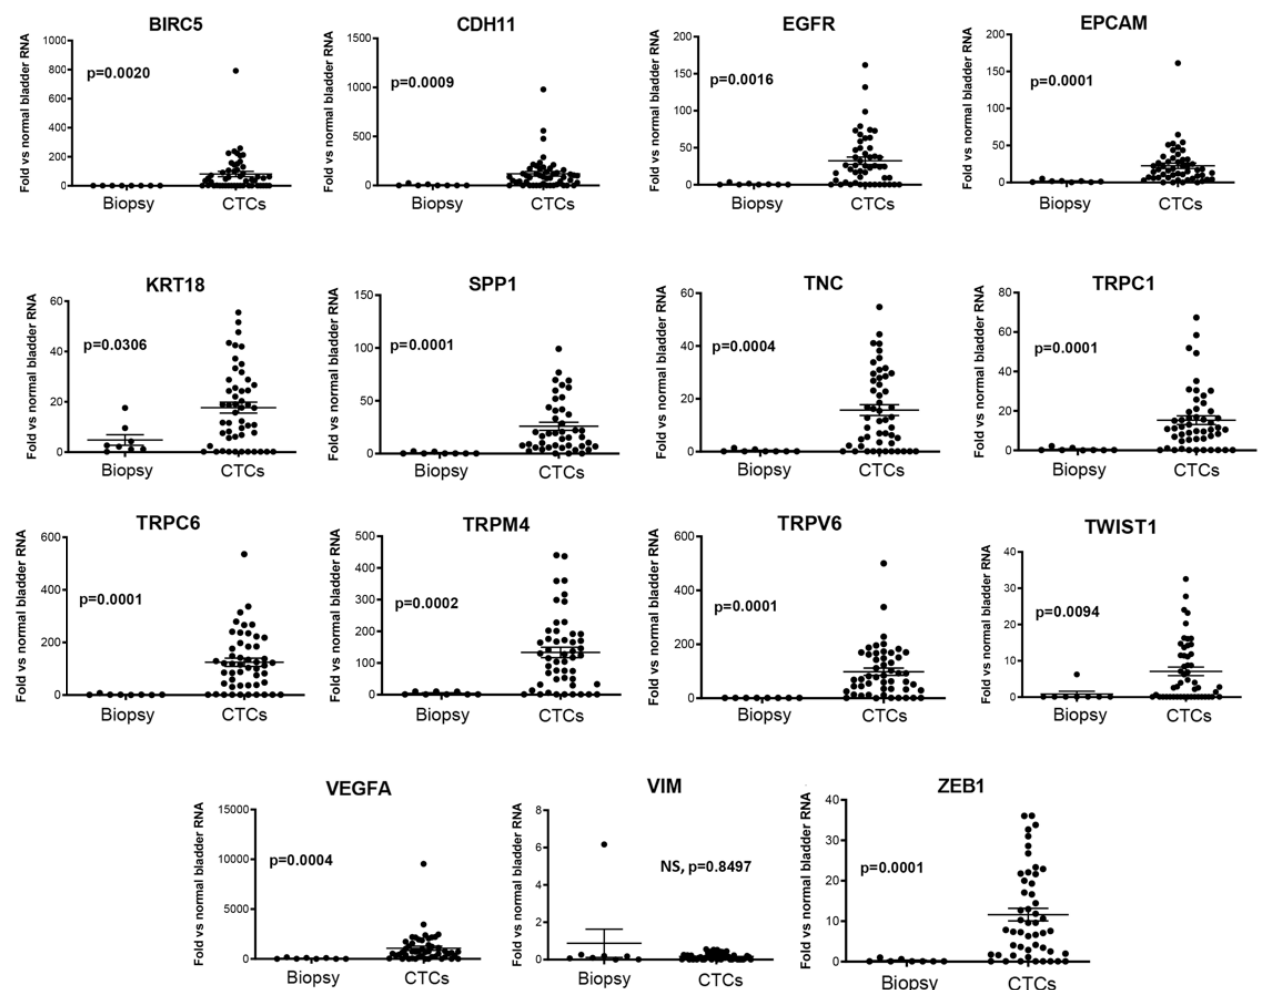
Figure 4. The expression of biomarker candidates in the CTCs isolated from BC patients. The expression was evaluated by ddPCR compared with the NHB and BC biopsies. Genes found to be expressed at significant higher/lower levels in CTCs with respect to the BC biopsies or NHB, are shown. The gene expression levels, evaluated by ddPCR, are expressed as fold changes with respect to NHB, used as calibrators (=1). NS = not statistically significant, p ≤ 0.05 was considered as statistically significant.